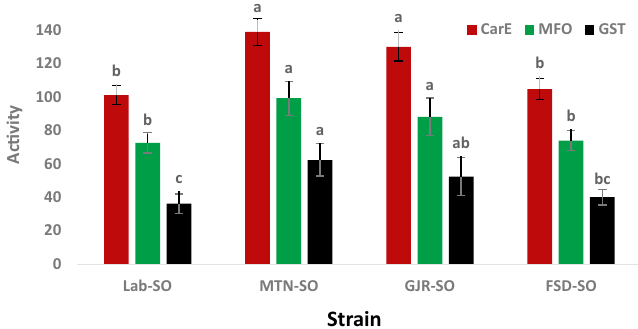
Figure 1. Activities of CarE (nmol/min/mg), MFO (pmol/min/mg) and GST (nmol/min/mg) in the Lab-SO strain and the most resistant strains (MTN-SO, GJR-SO and FSD-SO strains) of S. oryzae . Bars of a specific color (mean ± S.E.) with different letters are significantly different based on ANOVA and Tukey’s HSD